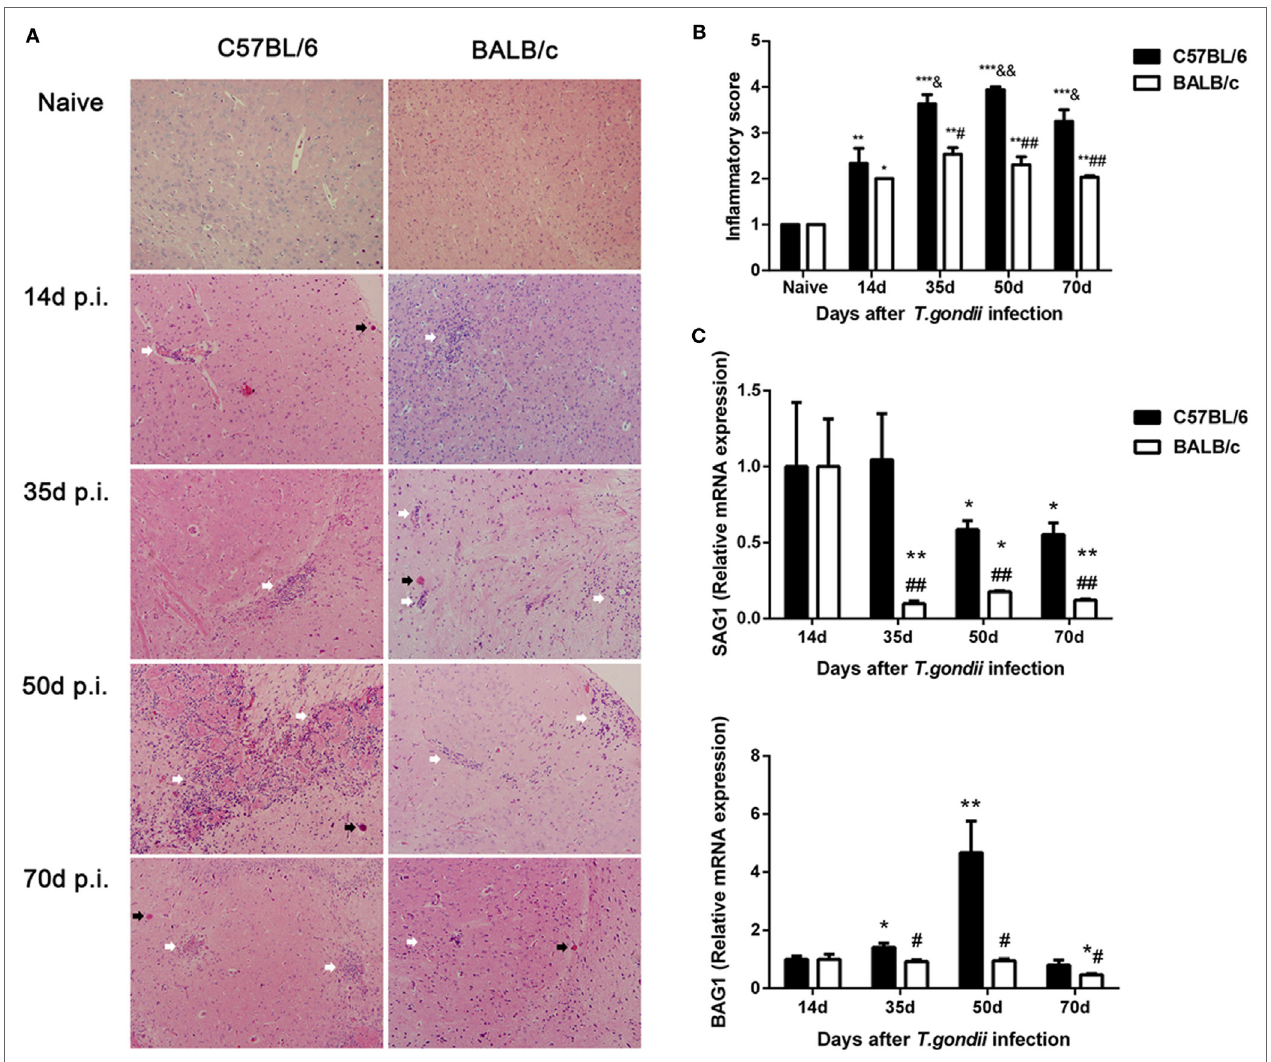
FigUre 1 | Histopathological changes and parasite burdens in the brains of Toxoplasma gondii Pru strain-infected C57BL/6 and BALB/c mice . (a) Histopathological changes in the brains at days 14, 35, 50, and 70 post infection (p.i.). Cysts were indicated with black arrow heads and inflammatory cell infiltrates were indicated with white arrow heads. Original magnification 200 × ; hematoxylin and eosin stain. (B) Histopathological score analysis at days 14, 35, 50, and 70 p.i. Data are represented as mean ± SEM. Significant differences between groups are analyzed by the Wilcoxon rank sum test. * P < 0.05, ** P < 0.01, and *** P < 0.001 vs naive; & P < 0.05 and && P < 0.01 vs 14 days p.i.; # P < 0.05 and ## P < 0.01 vs C57BL/6 mice. (c) Parasite burdens in the brains at days 14, 35, 50, and 70 p.i. Relative mRNA expressions of surface antigen 1 (SAG1) and bradyzoite-specific antigen 1 (BAG1) were detected by using quantitative real-time reverse